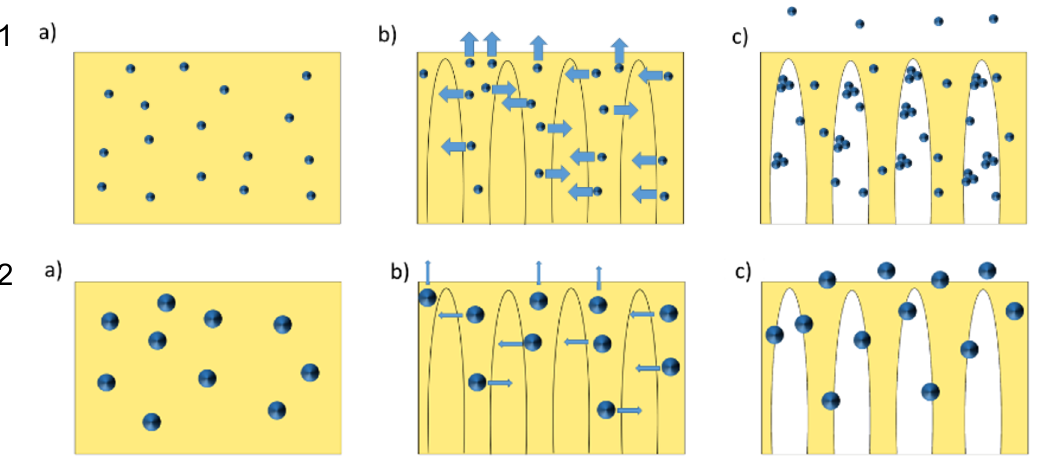
Figure 5. Schematic visualization of the behavior of nanoparticles in the dope solution during the phase separation. Case 1: not aggregated; case 2: aggregated. ( a ) dope solution; ( b ) during NIPS; ( c ) after NIPS).